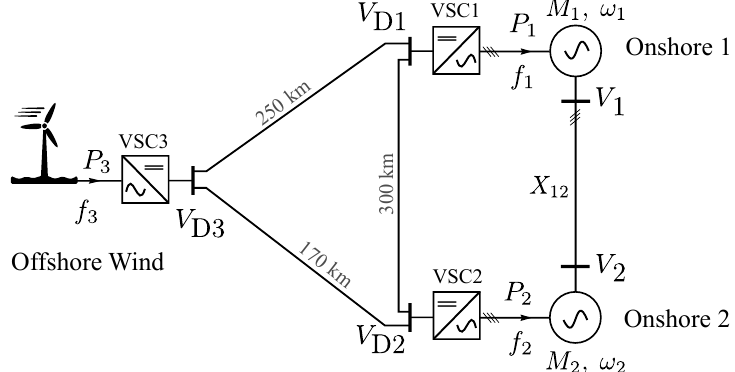
Figure 1. Offshore HVDC grid used for dynamic